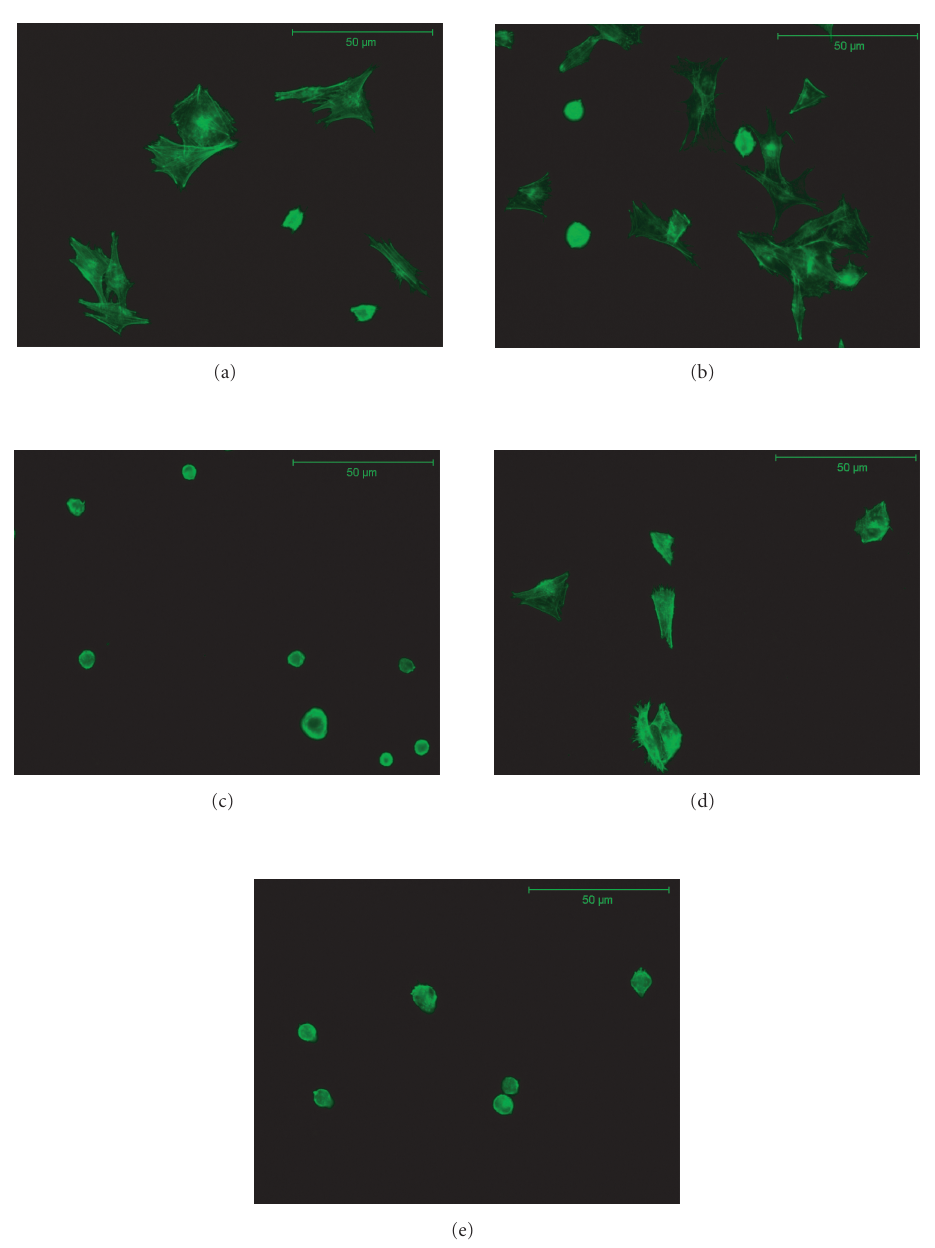
Figure 3: Rearrangement of actin cytoskeleton in treated and untreated MDA-MB 435 breast cancer cells. Cells were plated on fibronectin for 4hours in the presence of either compound 9 (panel (c)), compound A5 (panel (d)), or compound A8 (panel (e)) at a final concentration of 15.2 ng/ μ L and were compared to the positive control (panel (a)) and the ethanol vehicle (panel (b)).Cells were fixed and stained for F-actin using TRITC-phalloidin. Bar = 50 μ